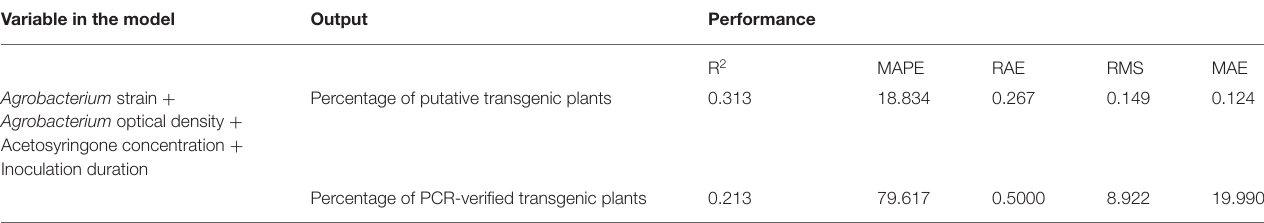
TABLE 4 | The performance of stepwise multiple regression to predict the percentage of putative and PCR-verified transgenic tobacco plants based on R 2 , MAPE, RAE, RMS, and MAE. Variable in the model